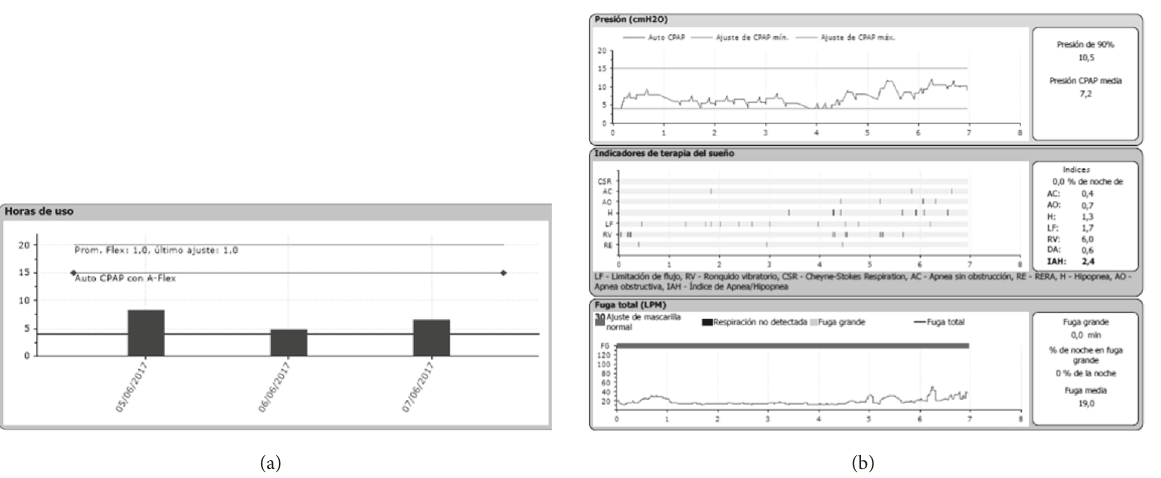
Figure 1: CPAP data during three nights (Software Encore Pro II). Note the vertical bars for use > 4 hours (a) and the pressure and leakage curves (b). The record corresponding to the night displayed showed no leakage and corrected rAHI with a pressure of 10 cm H 2 O (b).